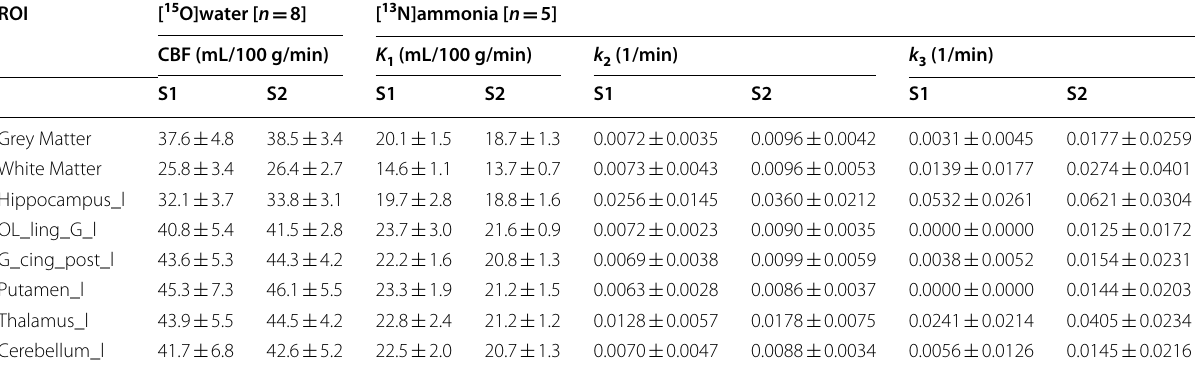
The table presents estimates of cerebral blood flow (CBF) from [ 15 O]water scans, and irreversible two tissue compartmental model parameter estimates for rate constants K 1 , k 2 and k 3 from [ 13 N]ammonia scans. Data are presented as mean standard deviation for grey matter, white matter and the left (l) hippocampus, lingual ± gyrus (OL_ling_G), posterior cingulate gyrus (G_cing_post), putamen, thalamus, and cerebellum